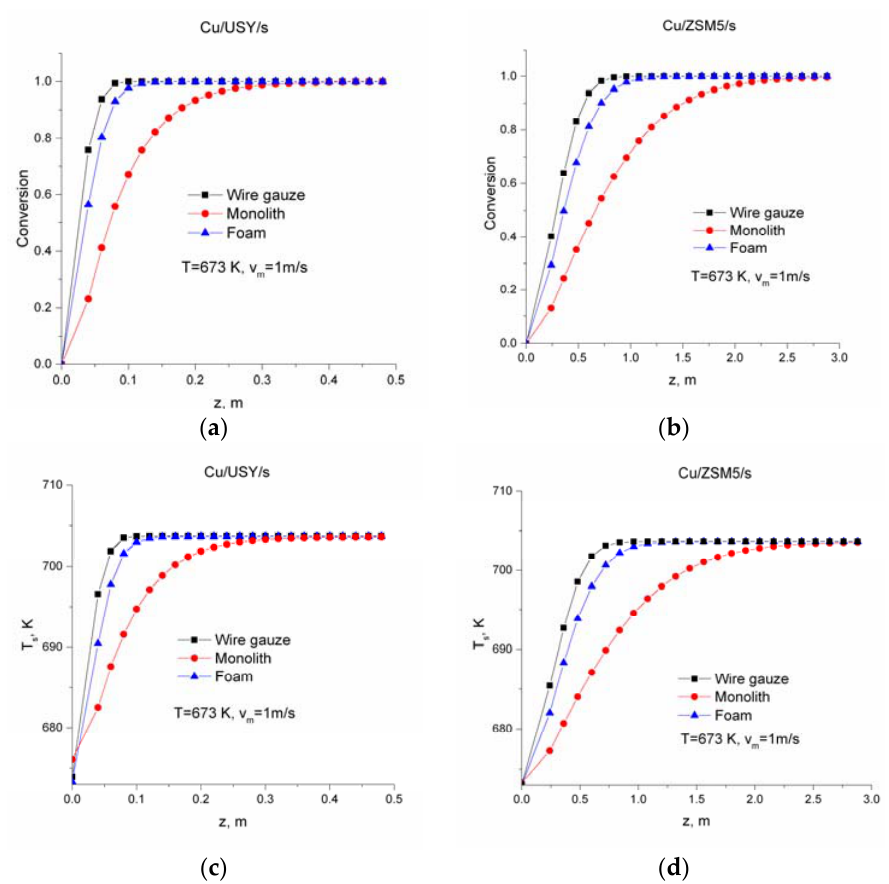
Figure 2. Comparison of different structured supports; superficial gas velocity 1 m/s, inlet gas temperature 673 K, NO concentration: 2500 ppm: ( a ) conversion profile along the reactor for Cu/USY/s; ( b ) conversion profile along the reactor for Cu/ZSM ‐ 5/s; ( c ) temperature profile along the reactor for Cu/USY/s; ( d ) temperature profile along the reactor for Cu/ZSM ‐ 5/s.